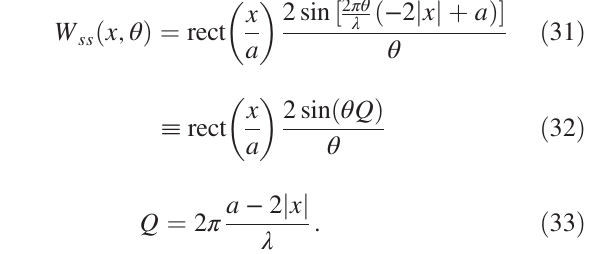
TABLE I. Numerical simulation